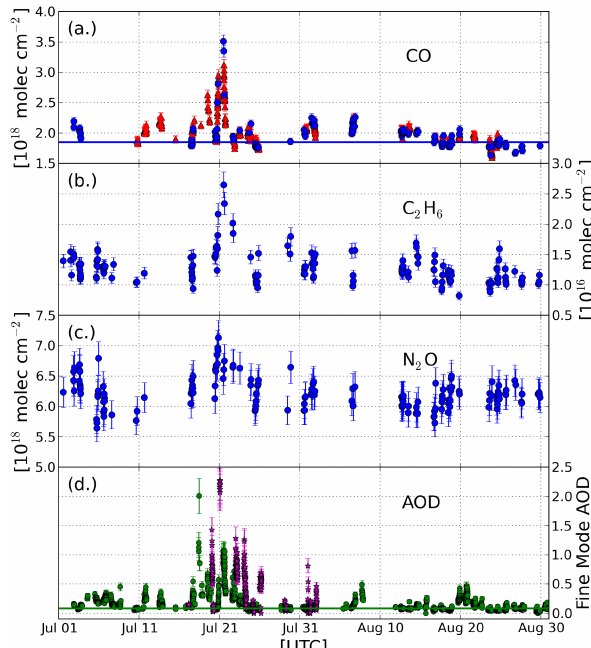
Figure 2. DGS remote-sensing measurements observed during the extended BORTAS campaign. (a) Total retrieved column of CO as measured by the DAO-DA8 (blue circles) and PARIS-IR (red tri- angles). Typical background column of CO above the DGS in the summer is shown by the horizontal blue line. ( b and c ) Total column of C 2 H 6 and N 2 O derived from DAO-DA8. (d) Fine-mode AOD derived from the CIMEL sun photometer (green circles), and star photometer (magenta stars). Background level of fine-mode AOD at the DGS is shown by the horizontal green